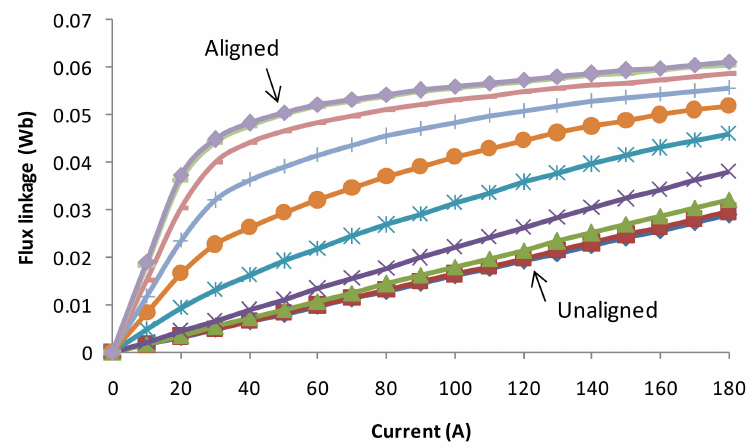
Figure 8. Flux linkage calculation from